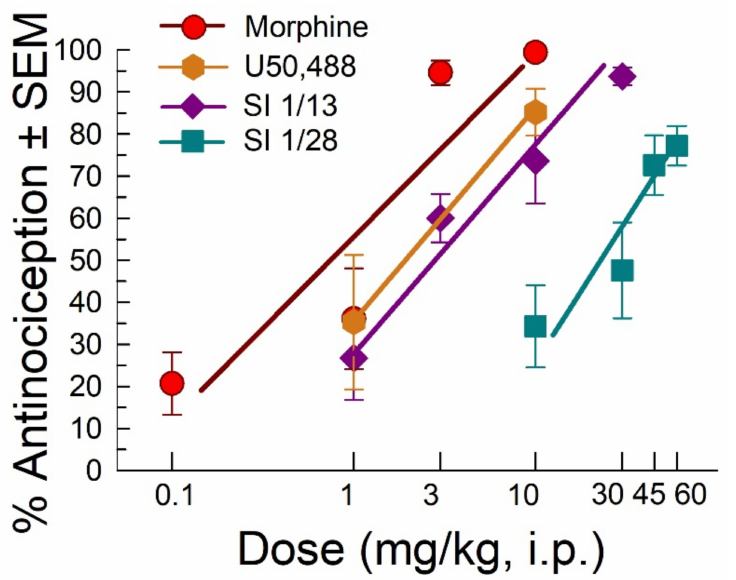
Figure 1. Dose-dependent antinociception of SI 1/28 following i.p. administration in the mouse acetic-acid writhing assay. Opioid agonists morphine, U50,488, and the parent S1R antagonist, SI 1/13 are shown as positive controls. All points represent average response ± SEM at peak effect, 30 min after administration in 7–10 mice.